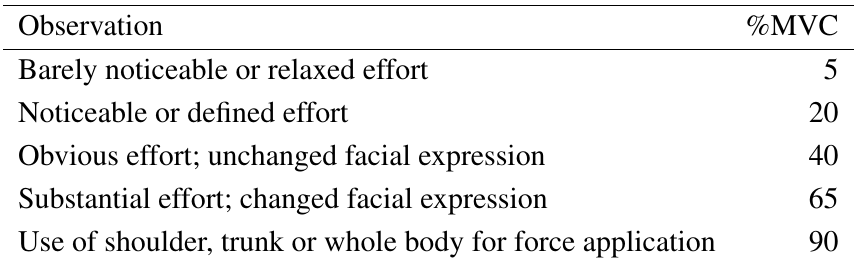
Table 3. Adapted Moore-Garg Strain Index, (Bernard, 2001).